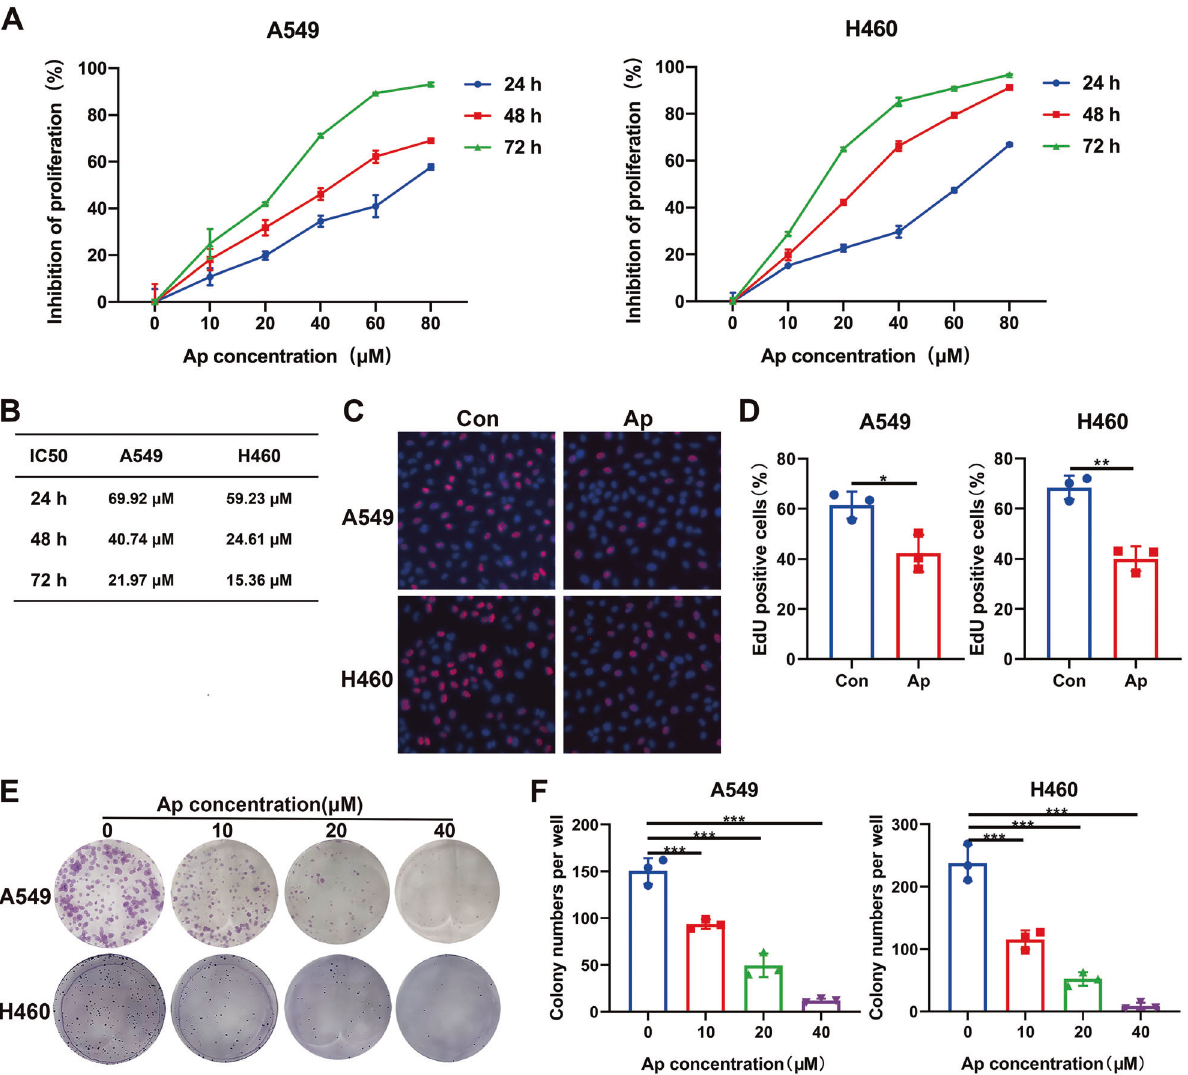
Fig. 1 Apatinib inhibited the proliferation of NSCLC cells. A A549 and H460 cells were treated with apatinib at various concentrations (0, 5, 10, 20, 40 μ M) for 24, 48, and 72 h. Viabilities of the cells were evaluated by CCK8 assays. B IC50 values of apatinib in A549 and H460 cells at 24, 48, and 72 h. C , D Representative images and statistical data of positive EdU staining (red) in NSCLC cells after treatment with 20 μ M apatinib for 48 h. E , F The images and data statistics of the colony formation assay of A549 and H460 cells treated with apatinib. Data are presented as mean ± SEM from three independent